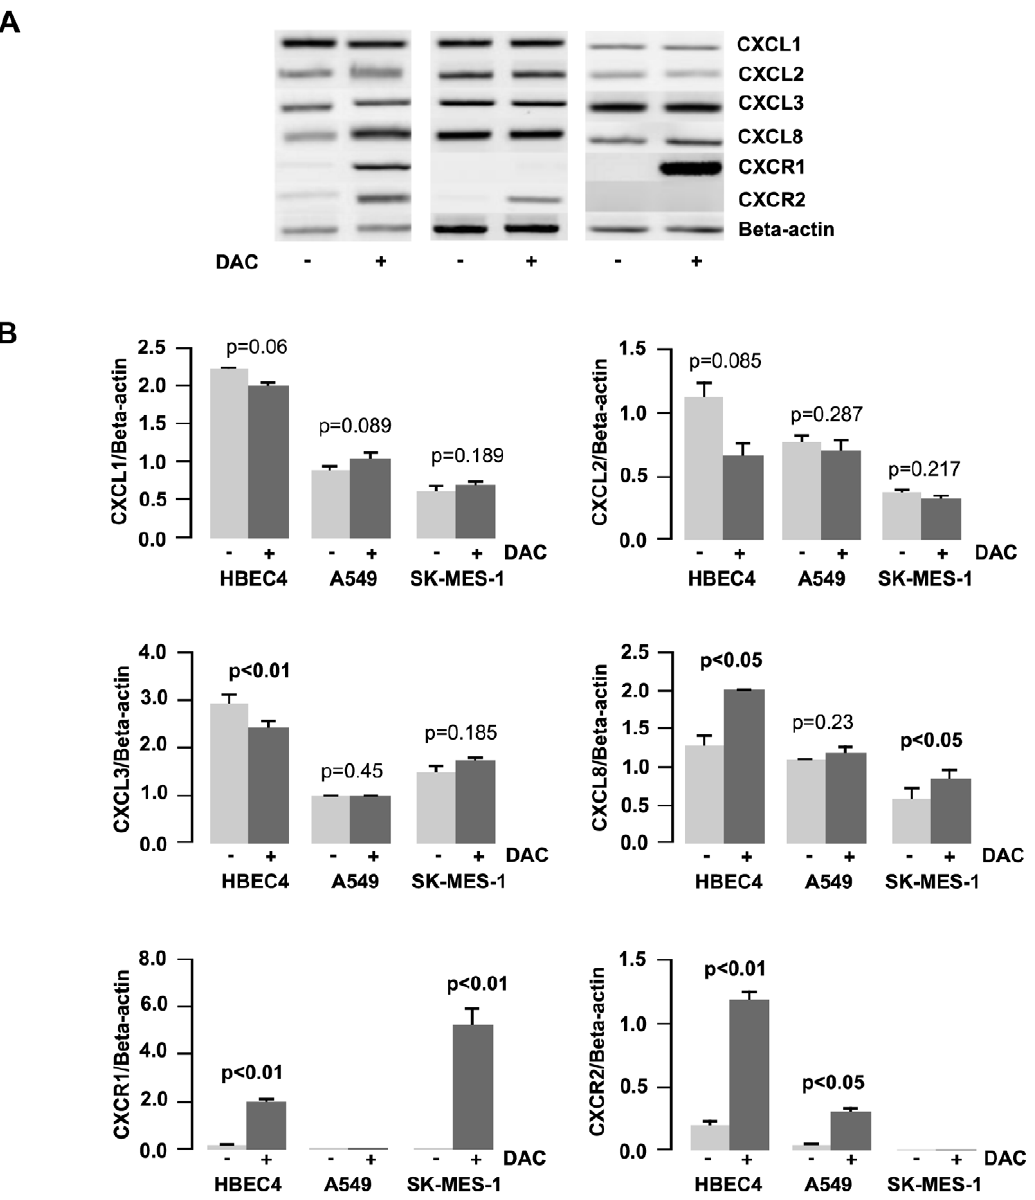
Figure 5. Cell line response to a DNA methyltransferase inhibitor. A) The effect of 5-aza-2 9 deoxycytidine (DAC) treatment on the expression of CXCL1 – 3 , CXCL8 and CXCR1/2 . Cells were cultured in 1 m M DAC for 48 h with media and drug replaced every 24 h. Expression changes were measured using RT-PCR with Beta-Actin used as the internal control for quantification purposes. B) Densitometry analysis of expression in treated versus untreated samples when normalised to beta actin . Data is graphed as mean 6 standard error of mean. (n=3). (DAC – 5-aza-2 9